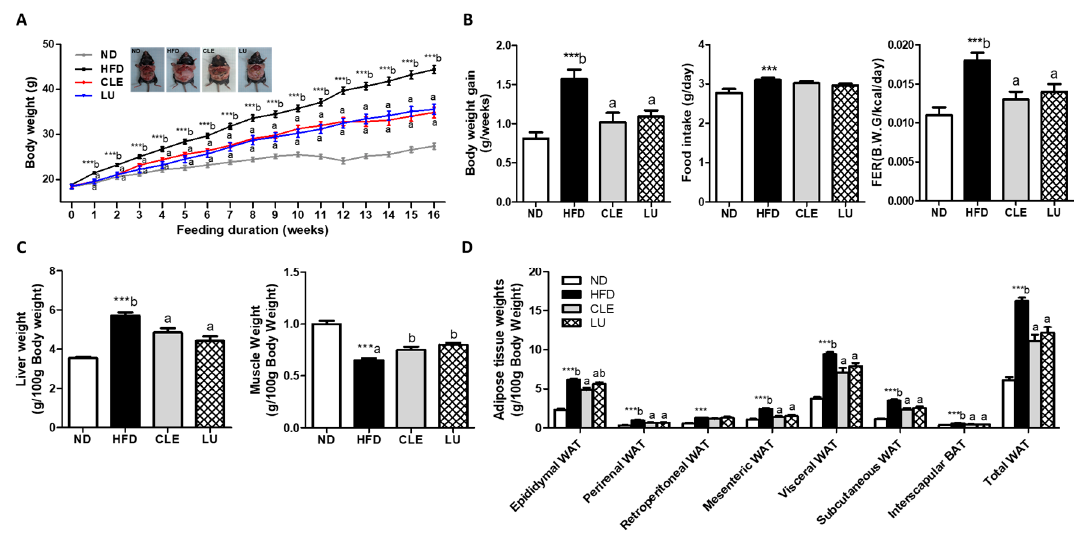
Figure 1. Effect of chrysanthemum leaf ethanol extract and luteolin supplements for 16 weeks on body weight in C57BL/6J mice fed a high-fat diet. ( A ) Weekly changes in body weight; ( B ) body weight gain, food intake, and food efficiency ratio (FER, body weight gain/energy intake); ( C ) organ weights (D) adipose tissue weights. Data are mean ± SE. Significant differences between HFD compared to ND are indicated *** p < 0.001 (Student’s t -test). ab Means not sharing a common letter are significantly different among the HFD-fed groups at p < 0.05. ND, normal diet (AIN-76); HFD, high-fat diet (45% kcal from fat); CLE, HFD+chrysanthemum leaf ethanol extract (1.5%, w / w ); LU, HFD+luteolin (0.003% w / w ). WAT, white adipose tissue; BAT, brown adipose tissue.